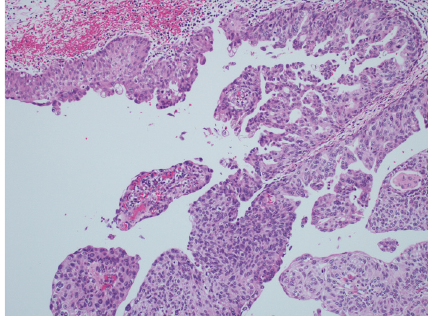
Figure 4: A low power view of the papillary urothelial carcinoma projecting into the renal pelvis. Carcinoma in situ is present in the adjacent urothelial